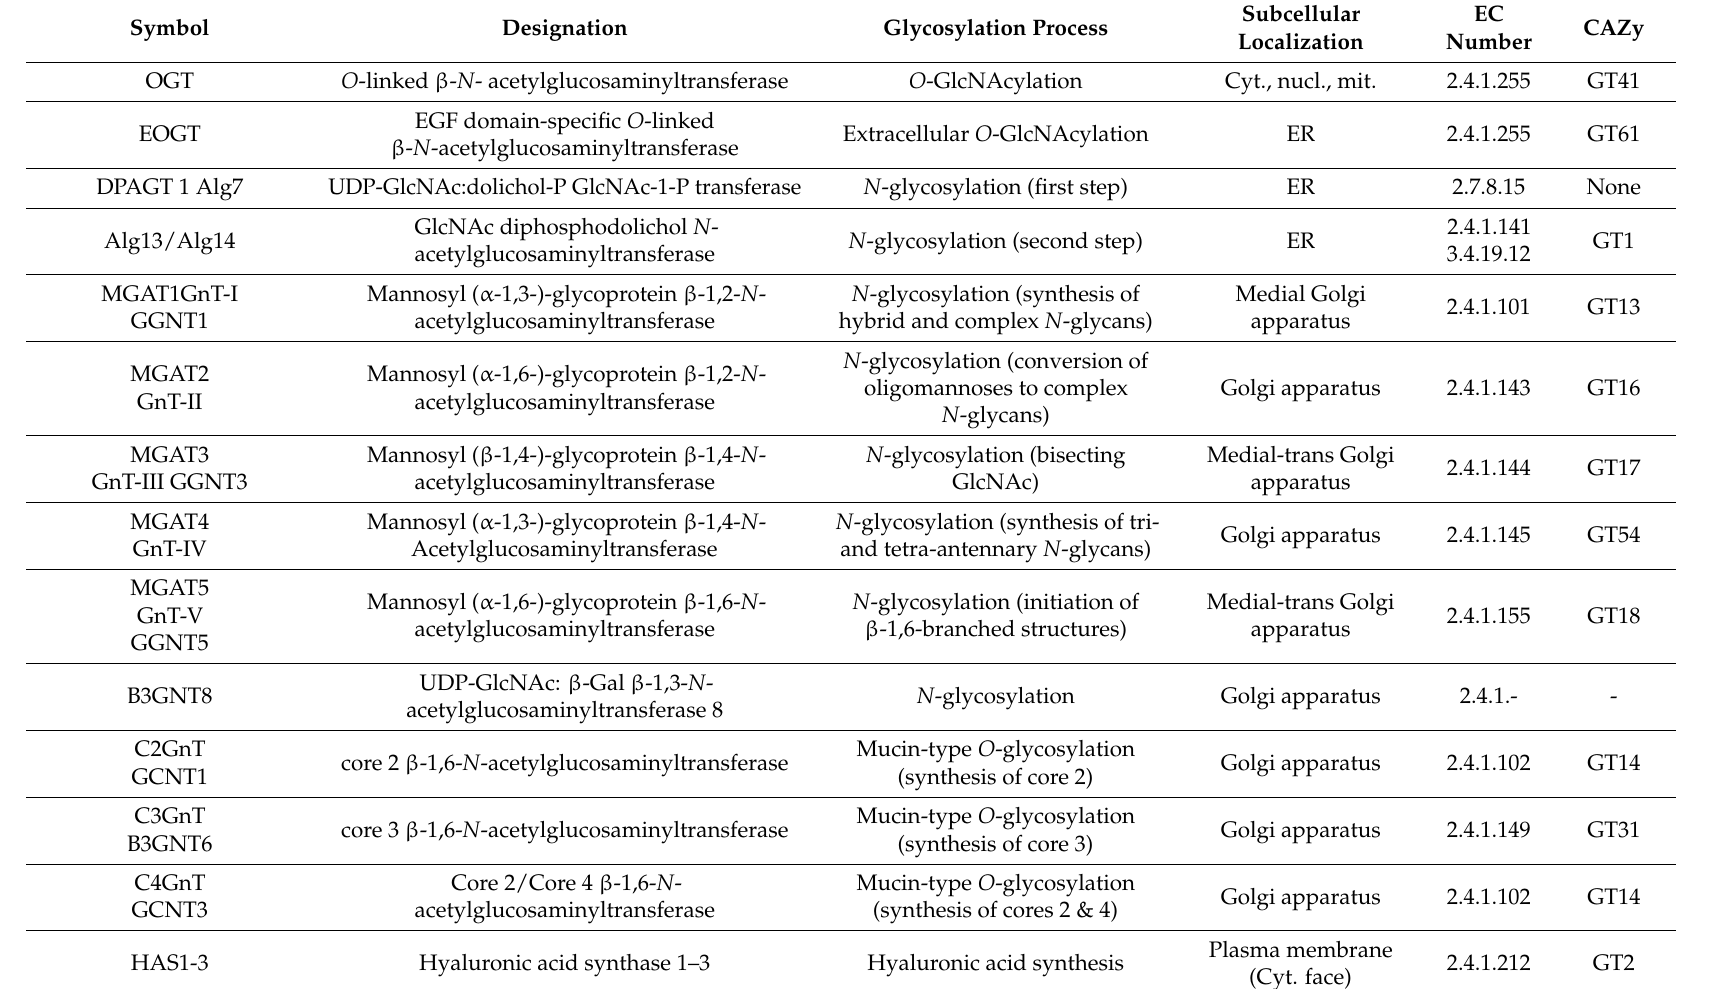
Table 1. Main enzymes competing for